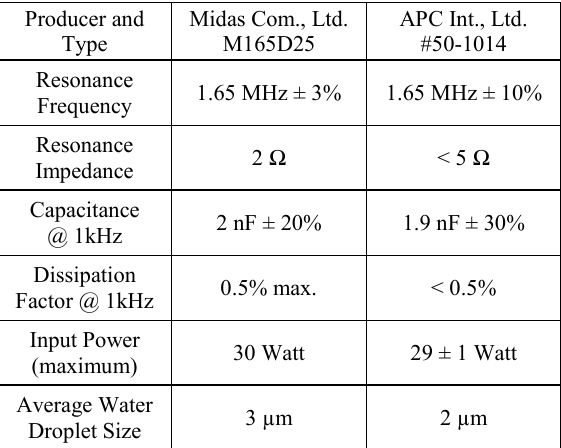
Table 1. Basic parameters of ultrasonic